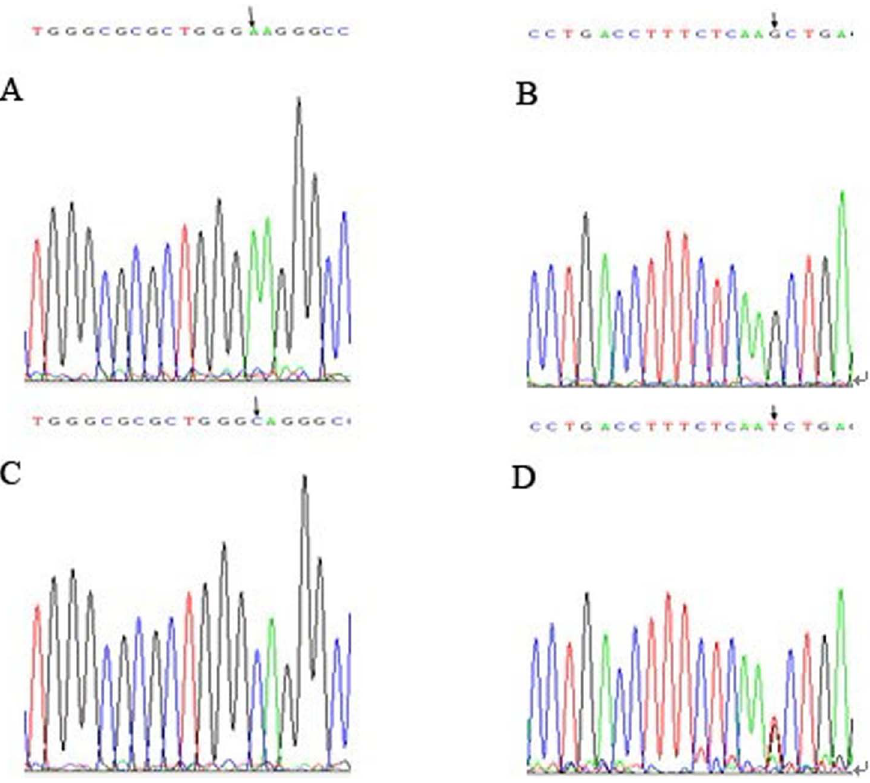
Table 1. Association between RASSF1A promoter hypermethylation status and clinicopathologic characteristics.